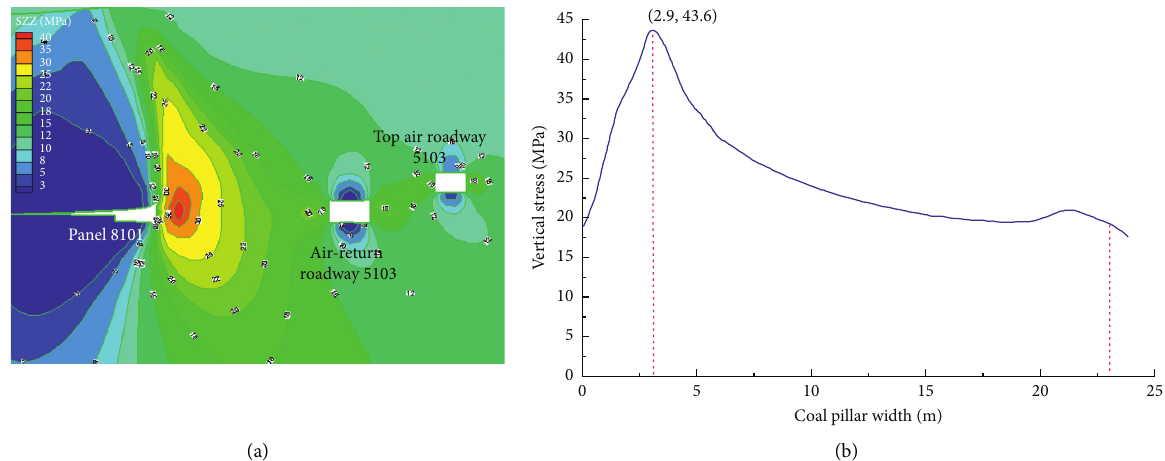
Figure 4: Vertical stress distribution of the surrounding rock and coal pillar in panel 8101. (a) Vertical stress of the surrounding rock. (b) Vertical stress of the coal